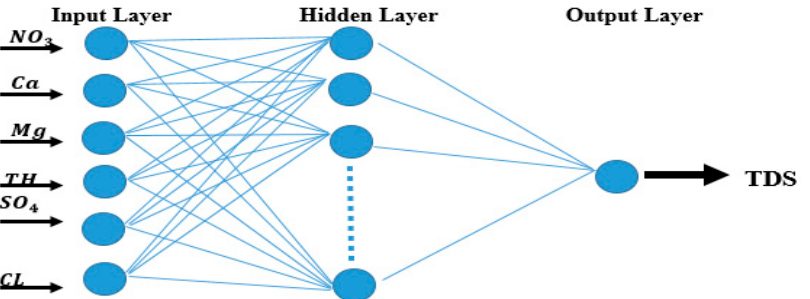
Figure 3. The architecture of the artificial neural network (ANN) model used for the predicted of total dissolved solids (TDS) in the Abu-Ziriq marsh, south of Iraq.